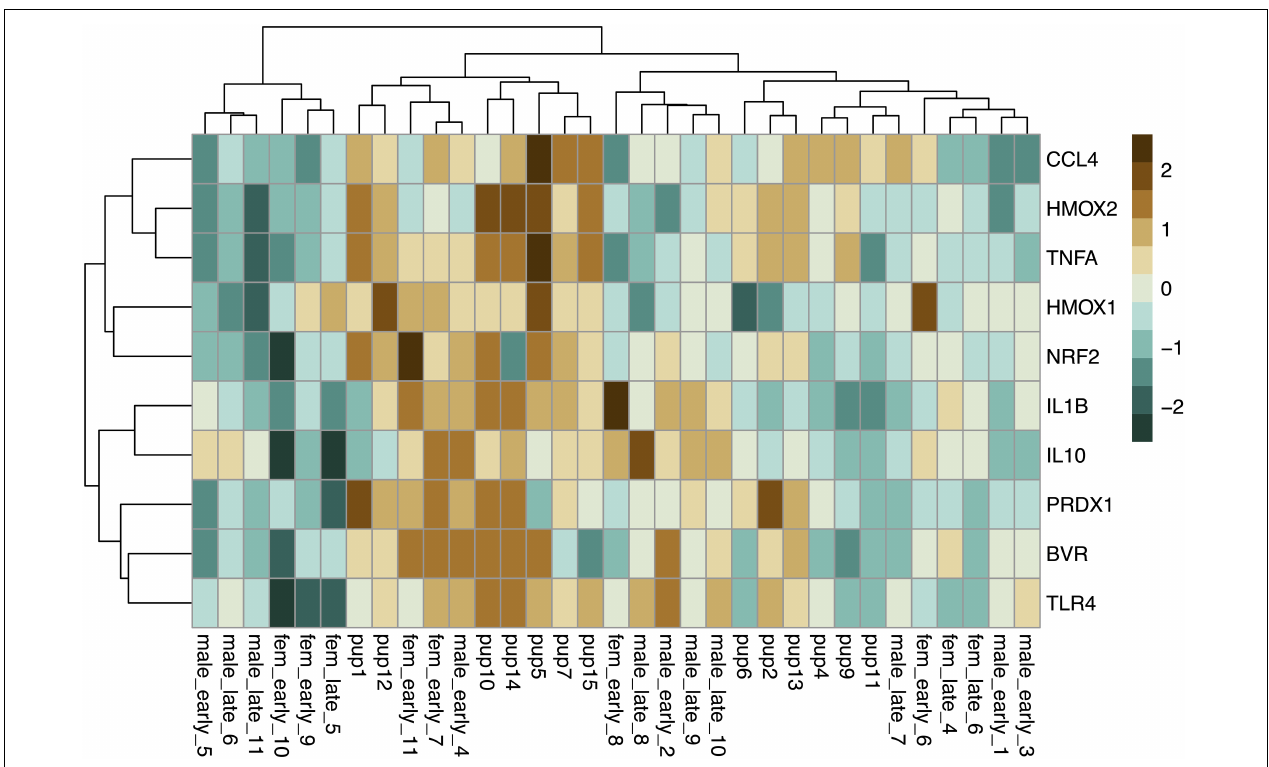
FIGURE 6 | Heatmap showing scaled baseline expression (delta C T ; higher: brown, lower: blue) of 10 genes (rows) associated with CO signaling, cytoprotection, and inflammation in whole blood of NES pups ( n = 13) and adults ( n = 20, columns). Rows and columns were clustered by Euclidean distance.